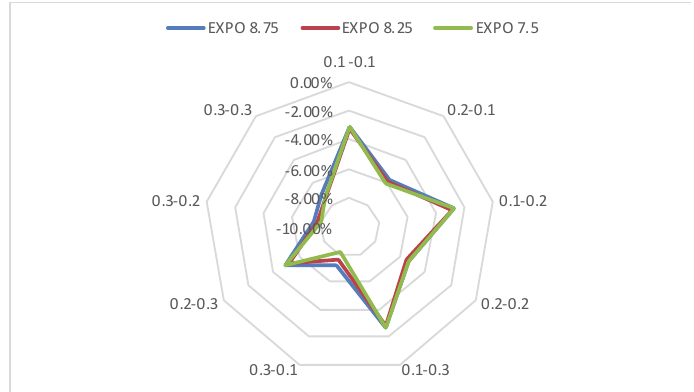
Fig. 11. Average Process Time